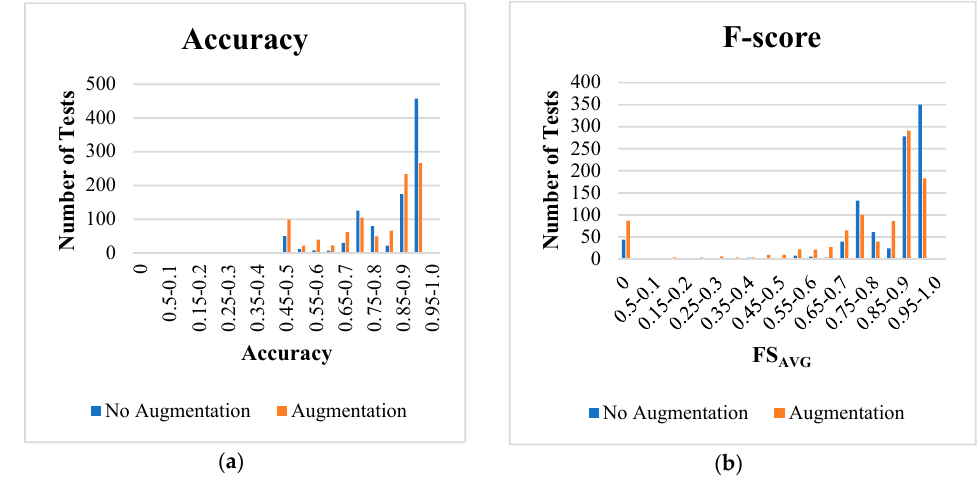
Figure 13. Number of tests for accuracy ( a ) and f-score ( b ).